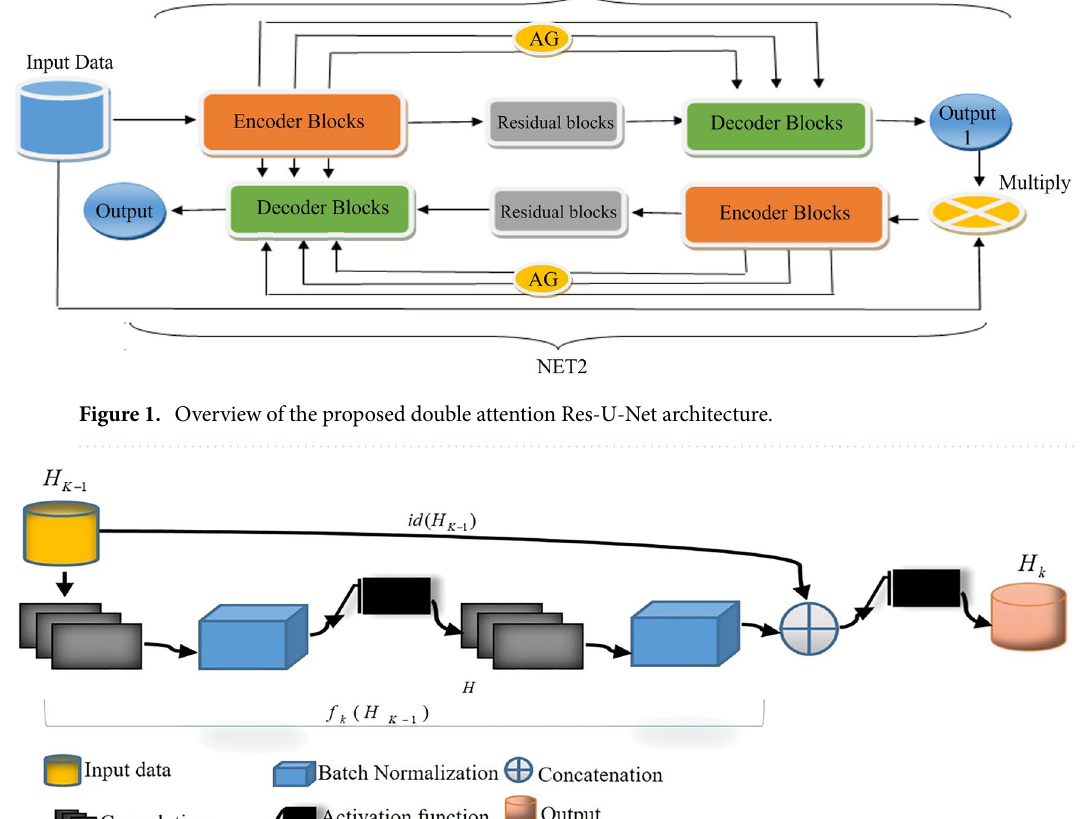
Figure 2. Overview of the proposed residual